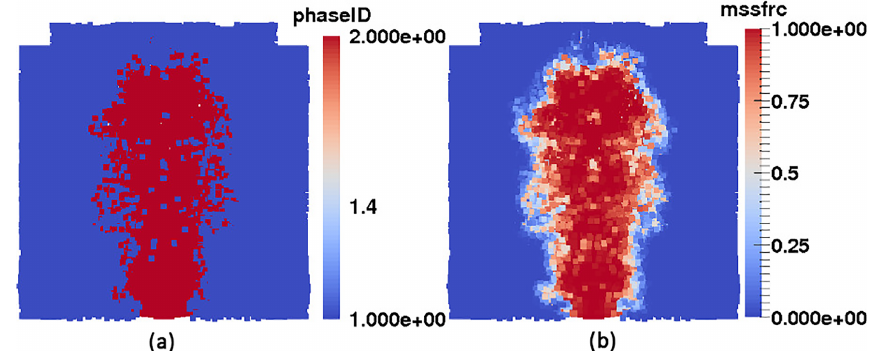
Figure 1. In panel (a) , the blue particles (phase 1) represent air particles; the red ones (phase 2) represent erupted material. Panel (b) shows corresponding mass fraction. Mass fractions are evaluated based on Eqs. (58) and (59) without any other interface track or capture